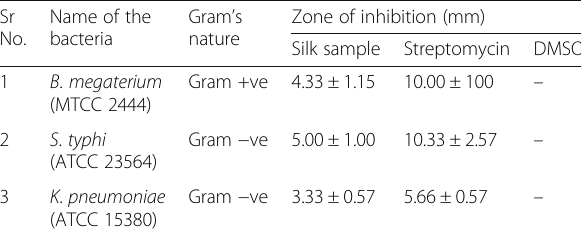
mined for C . albicans and A . flavus and it was 1.67 μ g/ ml and 3.34 μ g/ml respectively.